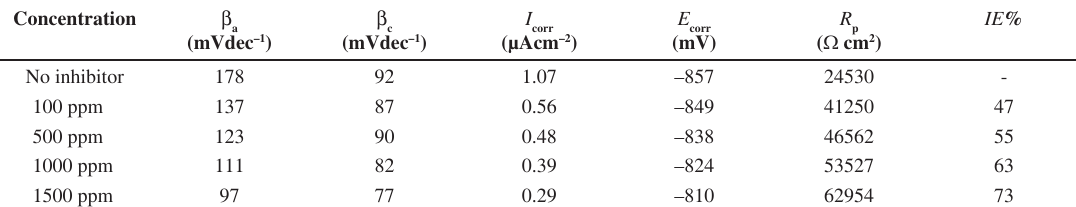
Table 3. Kinetic parameters of Al-2007 alloy in 3.5% NaCl medium containing different concentration of mad honey. Concentration